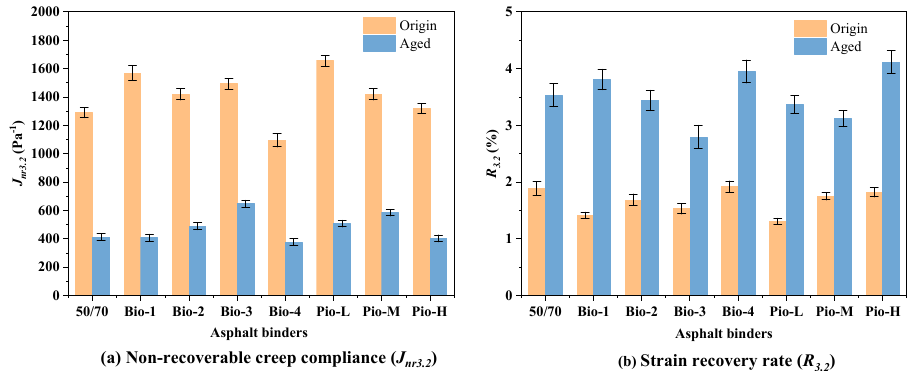
Figure 13. MSCR test results of all the asphalt samples: ( a ) non-recoverable creep compliance ( J nr3.2 ) ( b ) strain recovery rate ( R 3.2 ).